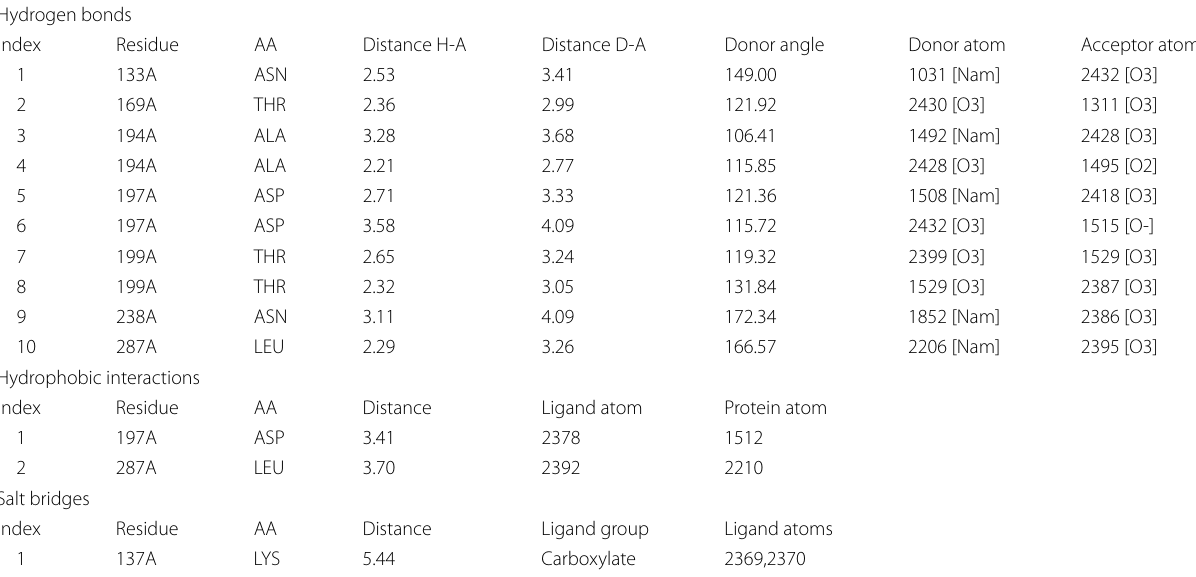
Table 5 Interactions of quercetin-3-neohesperidoside-7-rhamnoside with 3C-like protease Hydrogen